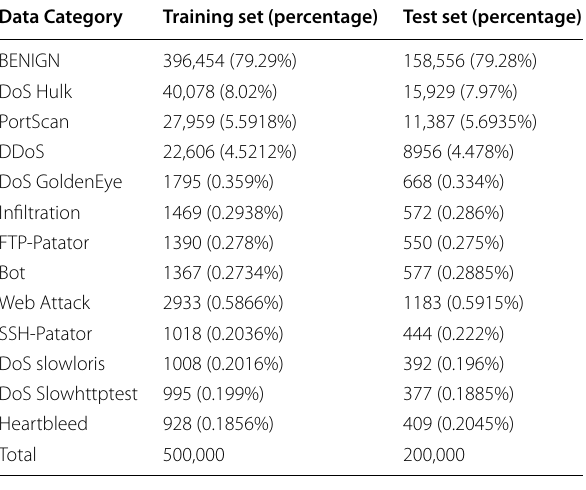
Table 2 CIC-IDS-2017 data distribution Data Category